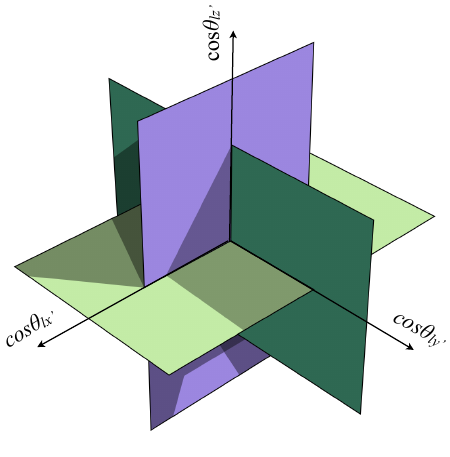
Figure 3 . Representation of the octant variable Q constructed by slicing the tridimensional phase space into eight octants, according to the signs of the three variables cos θ